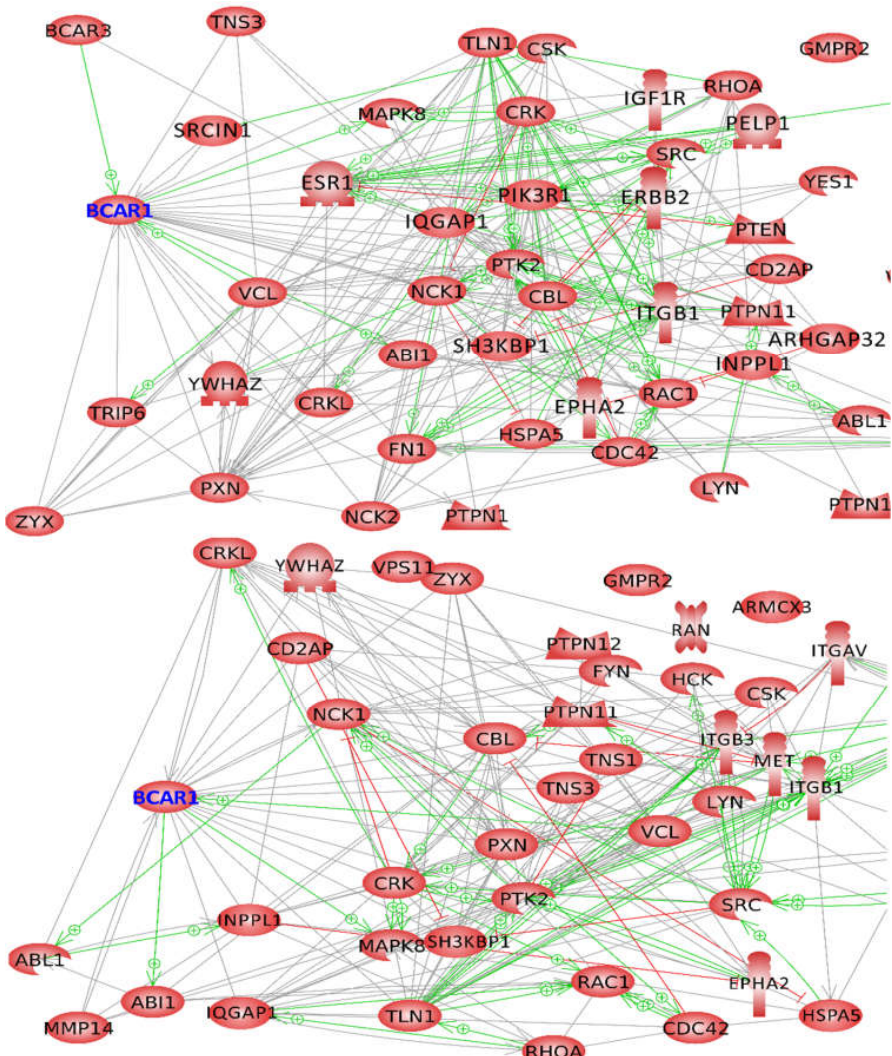
Figure 2. Interaction of the selected proteins obtained from proteome analysis of MCF-7 breast cancer cells ( upper picture ) and of FTC-133 thyroid cancer cells ( lower picture ). The icon labels refer to proteins by their human entry names (see also Table 1). The lines between the icons show various types of interaction. Gray lines indicate complex formation of the proteins connected with not exactly defined mutual influence. Green arrows point to complex formation with an activity enhancing effect on the protein at the arrowhead, red lines indicate complex formation with inhibition of the protein at the cross-piece. In both pictures, a gray connection line between BCAR1 and CRK indicates complex formation, while a green arrow between VCL and BCAR1 with the head near BCAR1 indicates activation of BCAR1 by VCL and a green arrow between BCAR1 and MAPK8 with the head near MAPK8 indicates activation of MAPK8 by BCAR1 . The interaction network was built using Pathway Studio v.12.3.